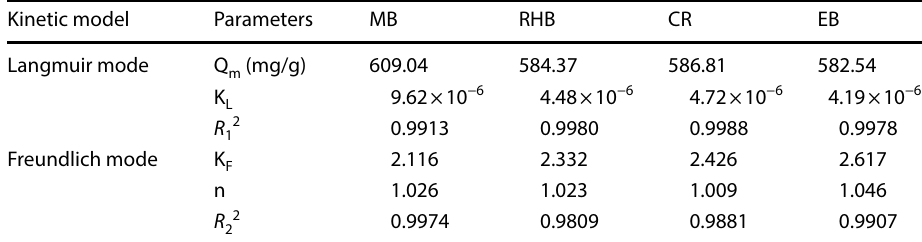
Table 2 Fitting parameters of PAA/PAM/[DMAEMA]MA hydrogel for MB, RHB, CR and EB adsorption isotherms